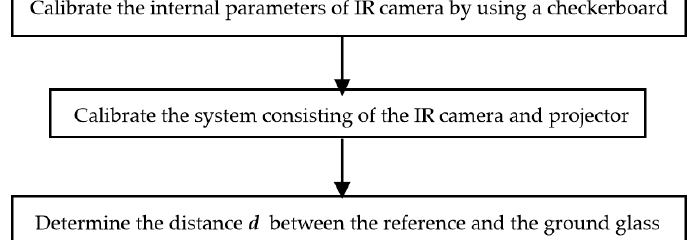
Figure 3. Flow chart of geometric calibration in IR-PMD.